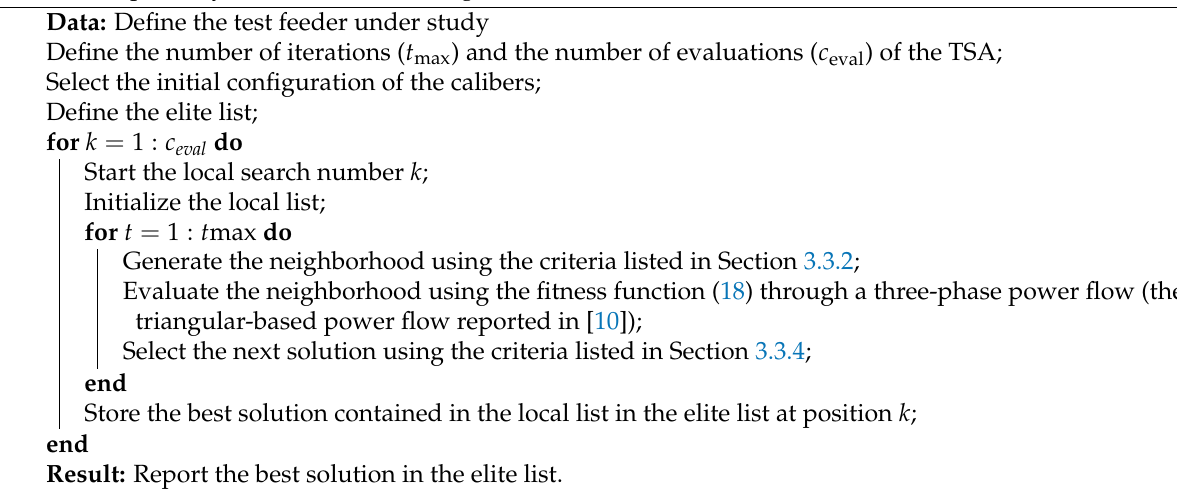
Algorithm 1: General implementation of the TSA to determine the optimal subset of calibers for all the routes in a three-phase symmetric distribution grid.